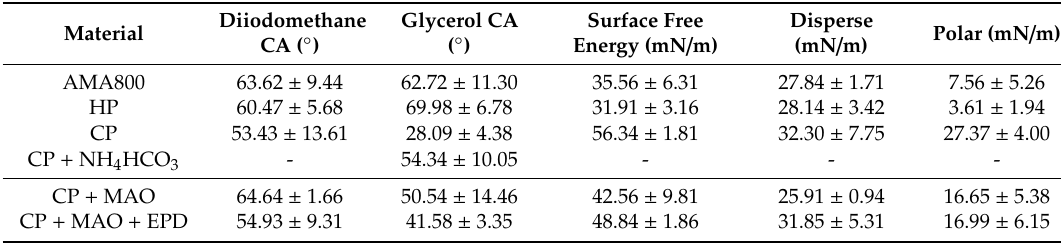
Table 6. Contact angle (CA), surface free energy with disperse and polar components for Ti23Mo alloys obtained by di ff erent processing